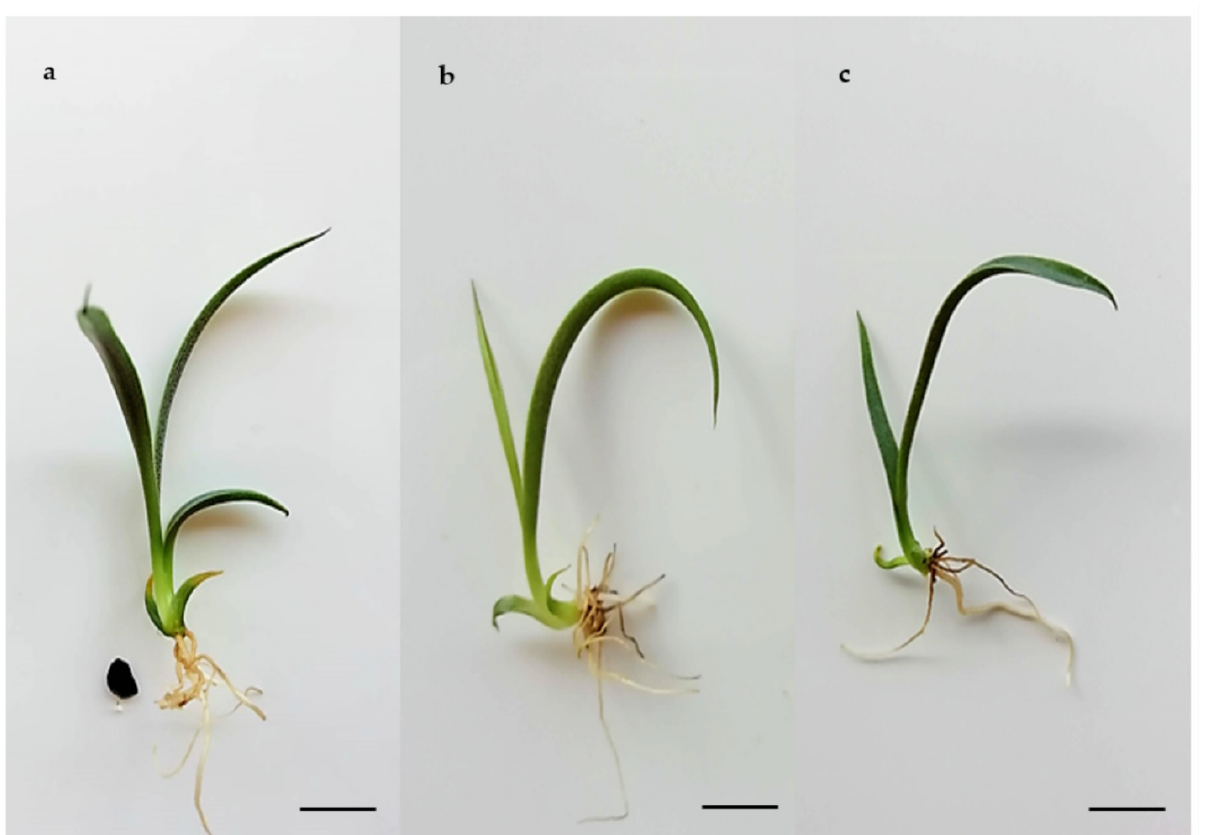
Figure 5. Conversion to plants of Agave tequilana Weber ‘Chato’. ( a ) Plant derived from zygotic embryo after 60 days of culture on MS medium (bar 2 cm), ( b ) Plant derived from non-cryopreserved SE after 60 days of culture on MS medium (bar 1 cm), ( c ) Plant derived from SE recovered after cryopreservation and cultivated for 105 days on MS medium (bar 1